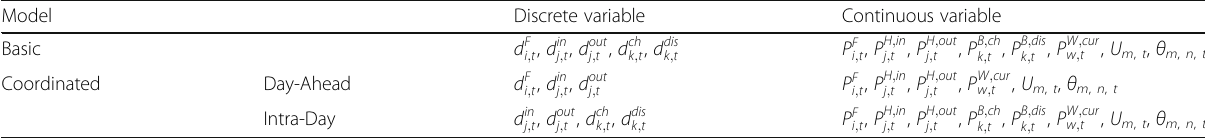
Table 1 The variables of the basic and coordinated dispatch models Model Discrete